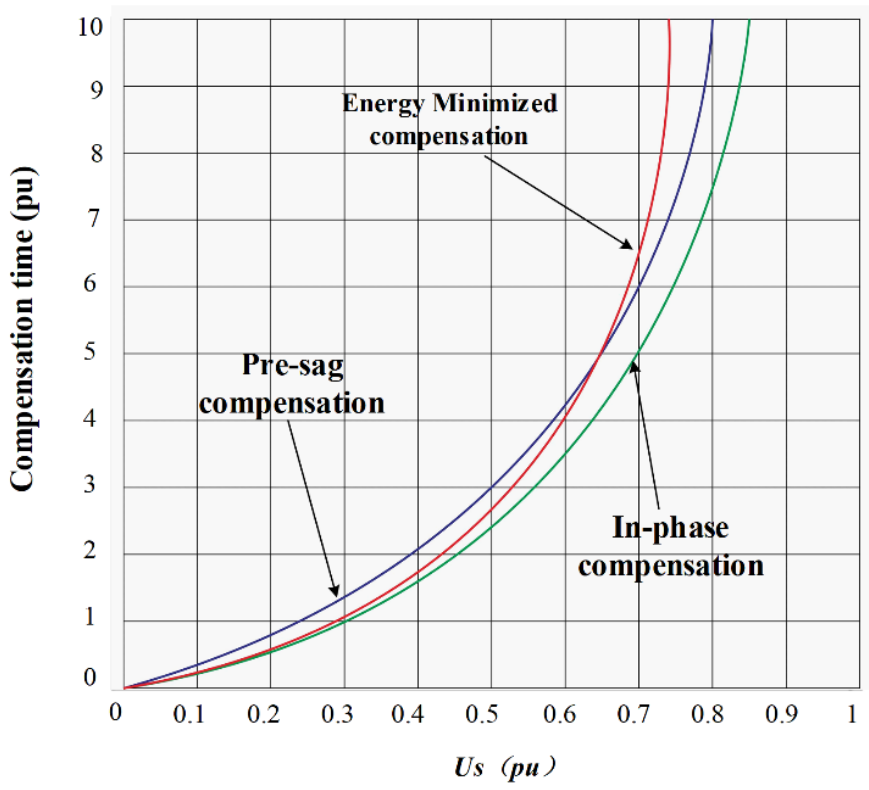
Figure 5. Compensation duration for three compensation strategies. After the above analysis of the compensation duration of the three commonly used compensation strategies and the analysis of the advantages and disadvantages of the three compensation strategies in Section 2.2 above, based on the advantages of energy-minimized compensation and pre-sag compensation, this paper proposes an integrated energy